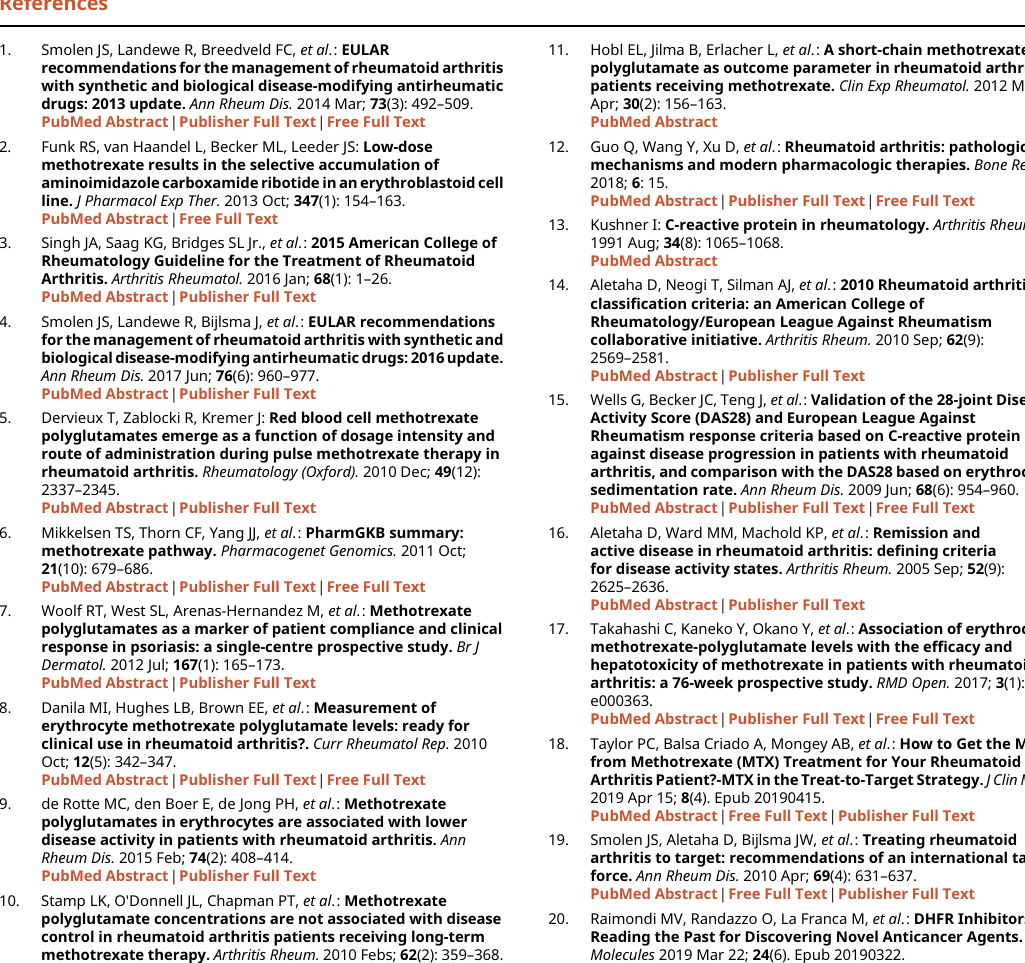
Figshare:STROBE checklistfor: ‘ Correlationbetweenserummethotrexate-polyglutamate3(MTX-PG3)levelanddisease activity in rheumatoid arthritis patients: A prospective cohort study ’ , https://doi.org/10.6084/m9.figshare.18743006. Data are available under the terms of the Creative Commons Attribution 4.0 International license (CC-BY